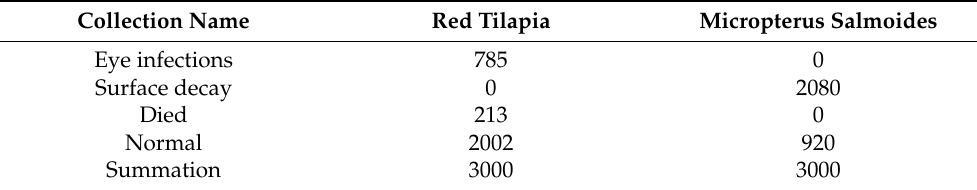
Table 1. Various state statistics of the fish in the dataset.